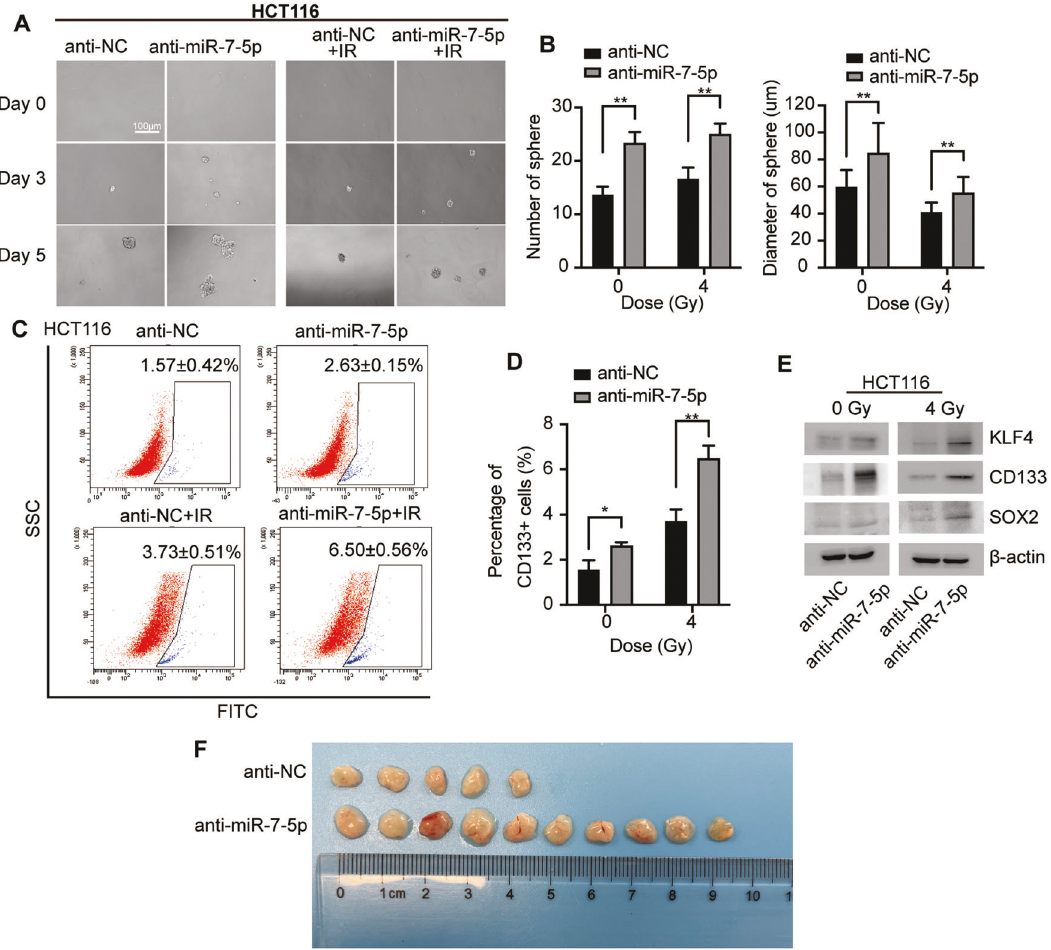
Fig. 4 Knockdown of miR-7-5p induced cancer cell stemness of HCT116 with or without irradiation. A Sphere formation assays using HCT116 cells after knockdown of miR-7-5p w/wo 4 Gy irradiation. B Quantitative analysis of A showed that downregulated miR-7-5p increased the sphere number and diameter in HCT116 treated with 0 or 4 Gy irradiation. C miR-7-5p knockdown in HCT116 increased the CD133 + CSC subpopulation under irradiation of 0 or 4 Gy. D Quantitative analysis of C . E Gene expression analyses showed positive regulation of stemness genes including KLF4, CD133 and SOX2 at the protein levels by knockdown of miR-7-5p in HCT116. F In vivo tumor initiation experiments illustrated that 5/10 (anti-NC group) versus 10/10 (anti-miR-7-5p group) of the injected HCT116 cells grew tumors eventually. Data are presented as mean ± SD; IR, irradiation (4 Gy); * P < 0.05; ** P < under normal and irradiation conditions, which may account for the potential inhibitory effect of miR-7-5p on CRC cell prolifera- tion and resistance to radiotherapy.